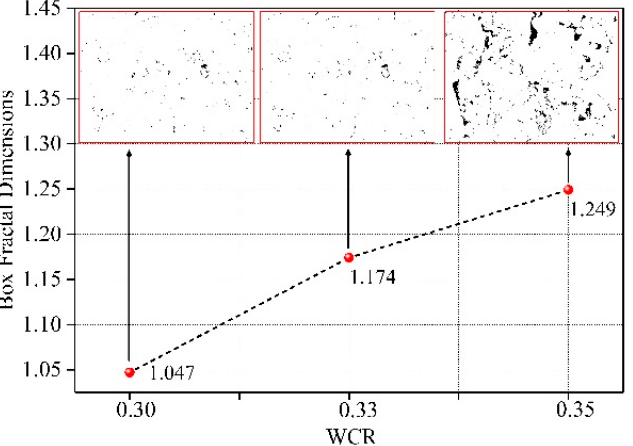
Figure 6. The influence of water-cement ratio on fractal dimension.